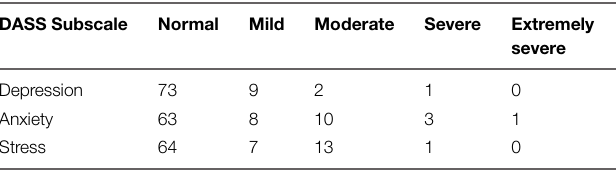
TABLE 1 | Number of subjects scoring in various ranges on each subscale of the Depression, Anxiety and Stress scale (DASS). DASS